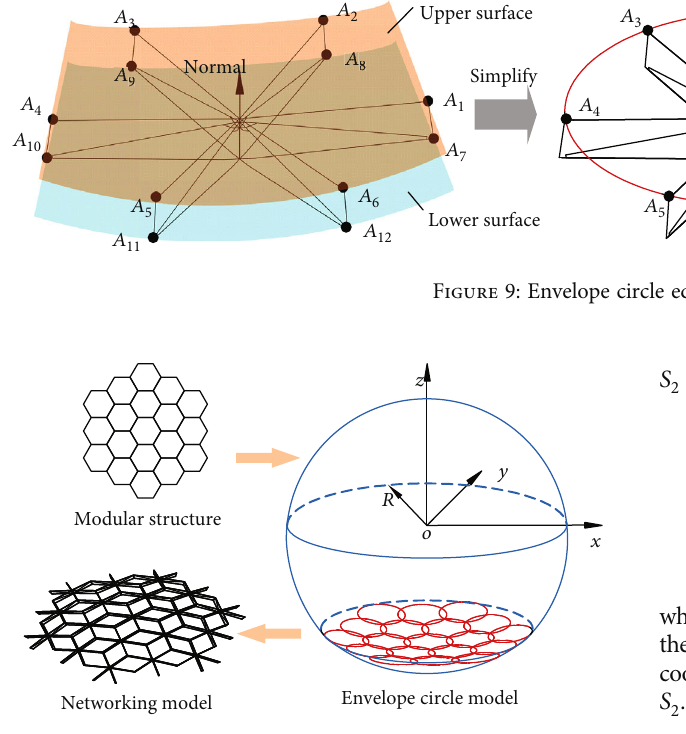
Figure 10: Research fl ow of multimodule networking.